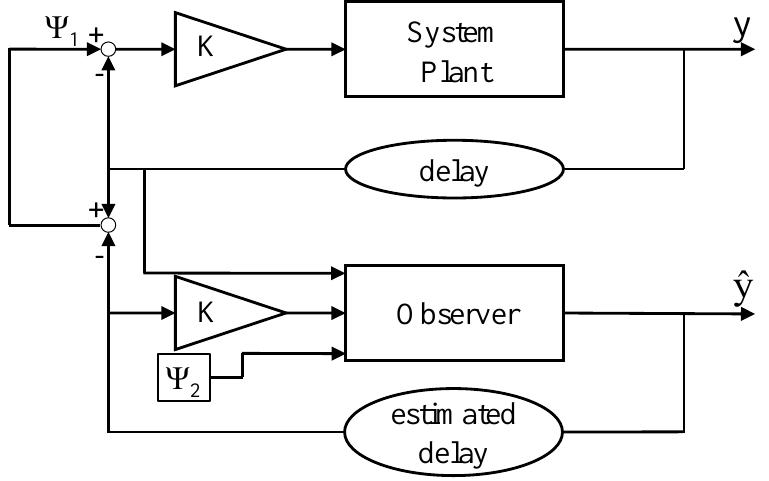
Figure 2. The proposed robust observer-based